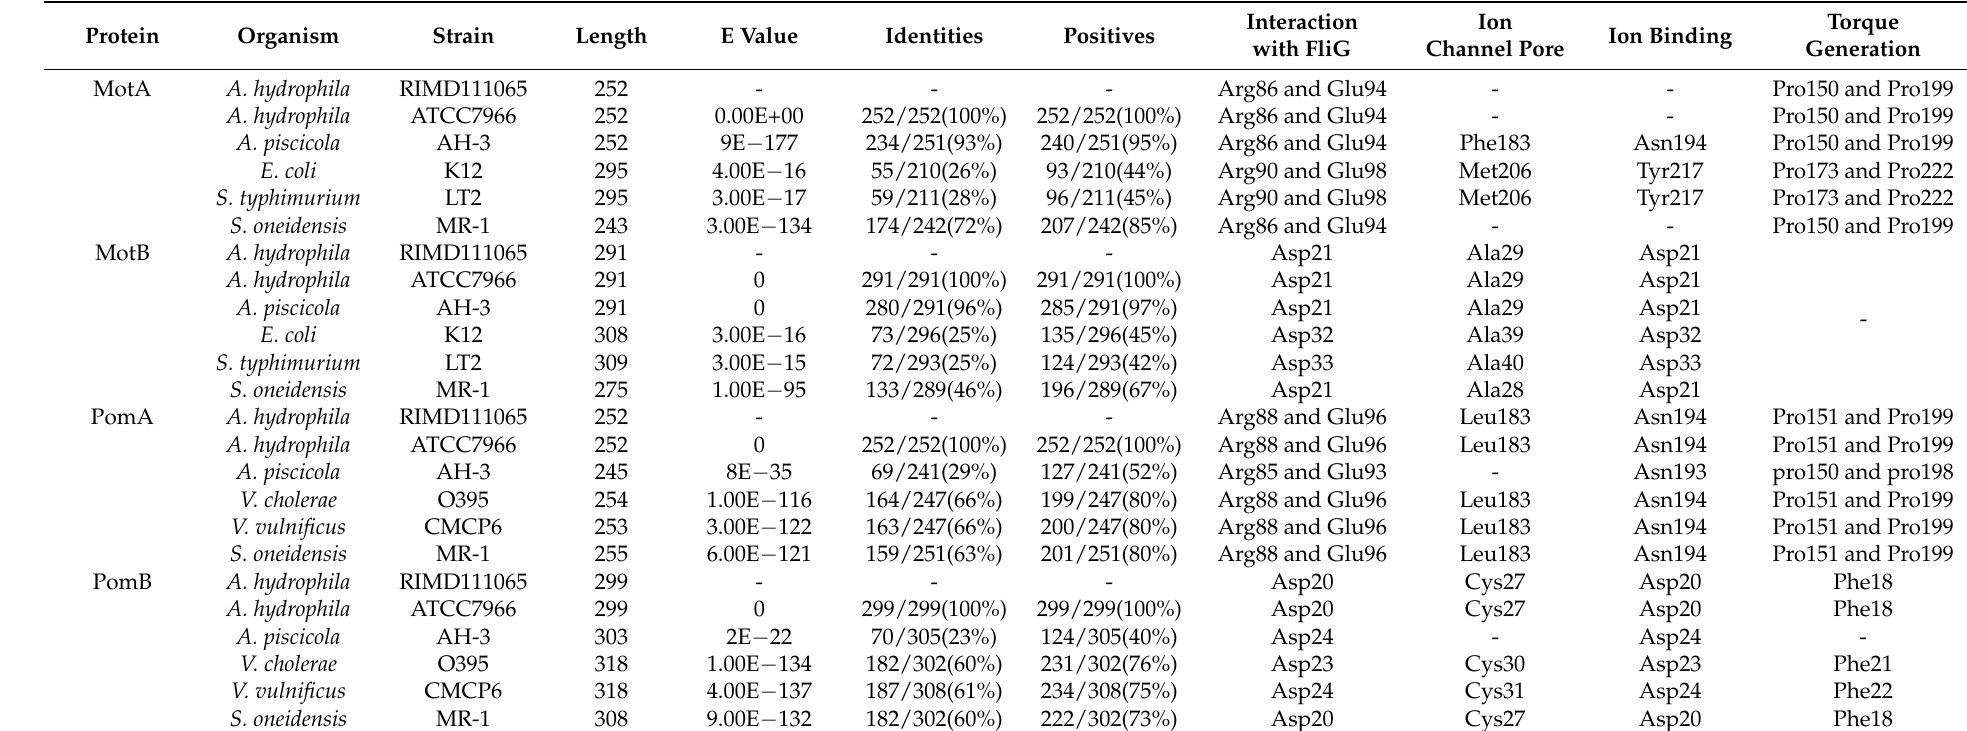
Table 1. The homology scores and key residues of stator proteins in RIMD111065 and